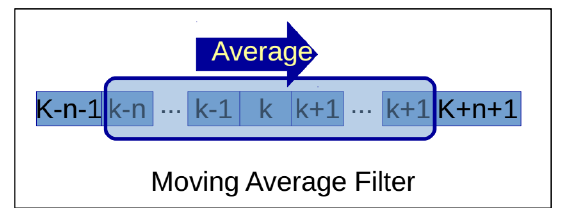
Figure 3. Simplified representation of the moving average